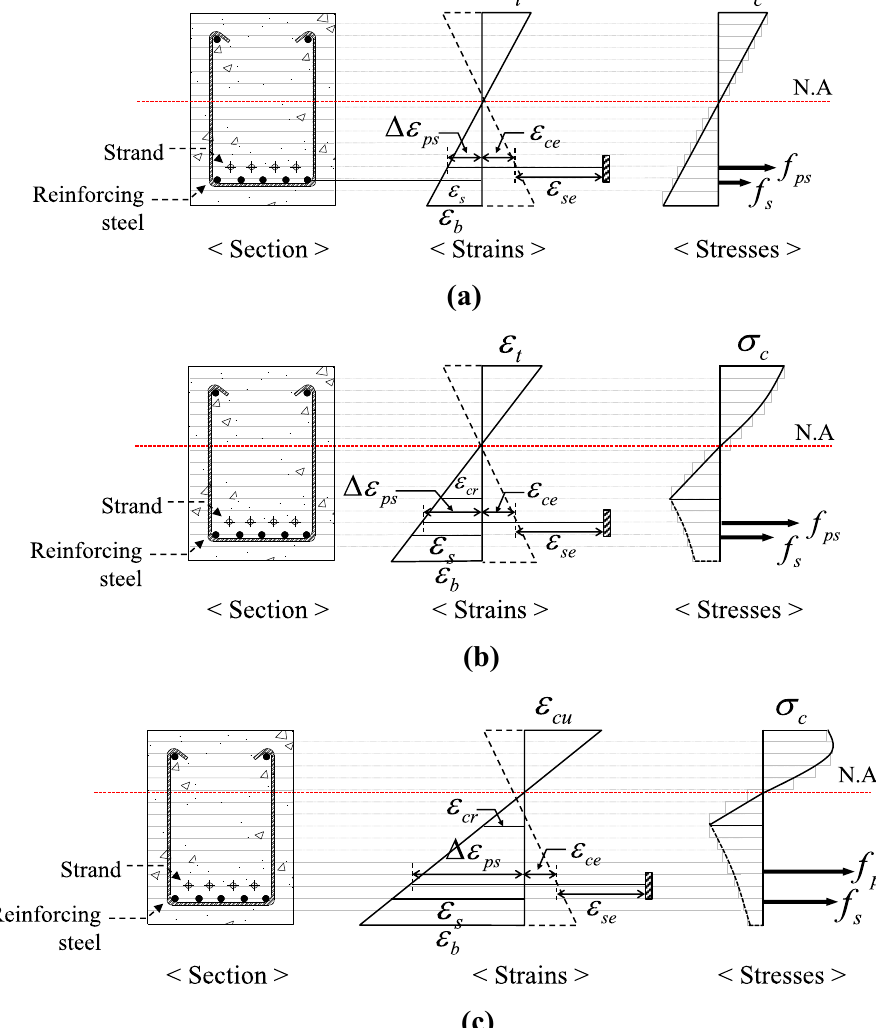
Fig. 3 Sectional analysis of prestressed concrete member. a Uncracked, b Cracked, and c